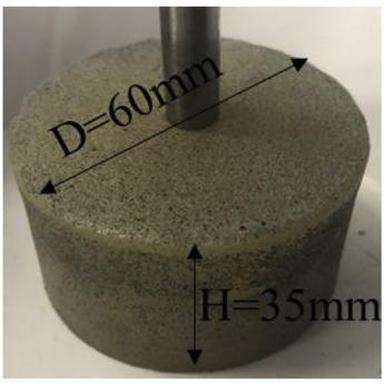
Specimen after aging.